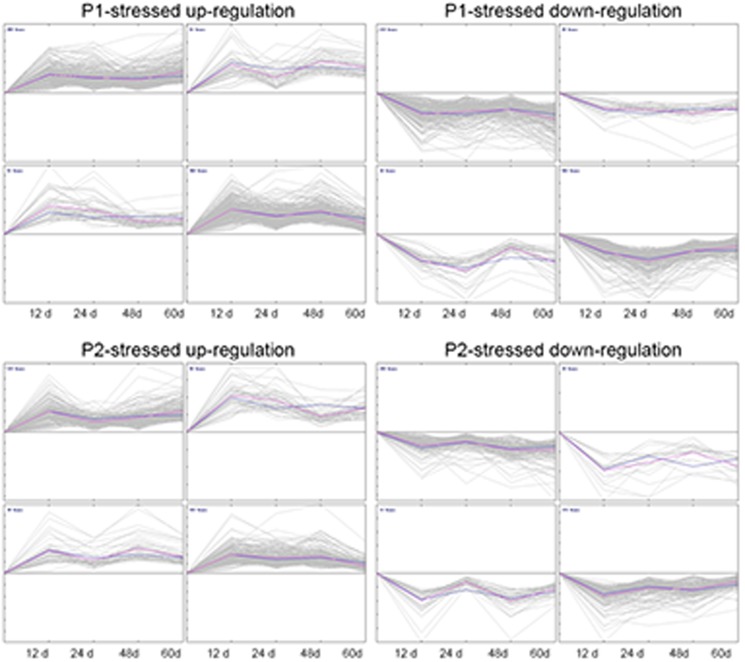
Division of genes differentially expressed by Pi-deficiency into four groups based changes in expression pattern.A time course of changes in expression pattern is shown. Seedlings under P0 conditions are included as a control. The x-axis represents time points after treatment, and the y-axis indicates the expression level.